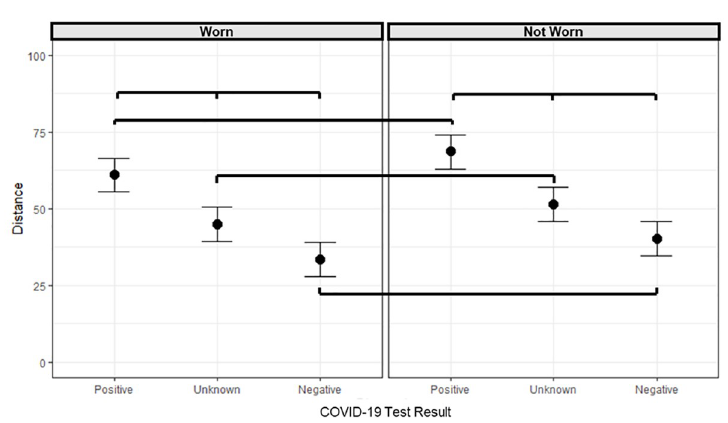
Fig 3. Parameter estimates from the interaction between COVID-19 test result and protective equipment. The central dot indicates the posterior median and the whiskers indicate the lower and upper limits of the 95% HDI. The contrasts for which the 95% HDI does not include zero and for which BF 10 > 3 (support for the alternative hypothesis) are connected with lines.